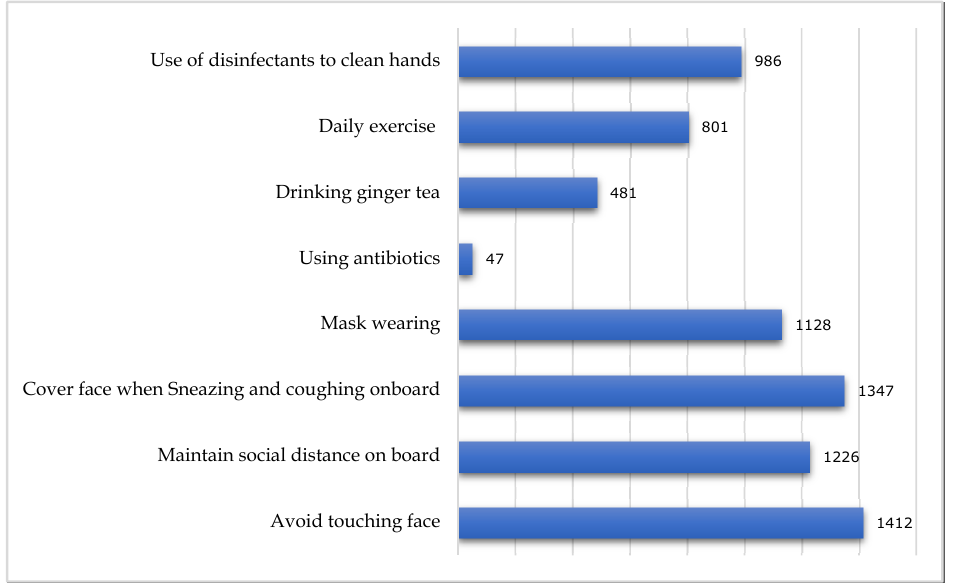
Figure 1. Onboard individual prevention measures by seafarers.